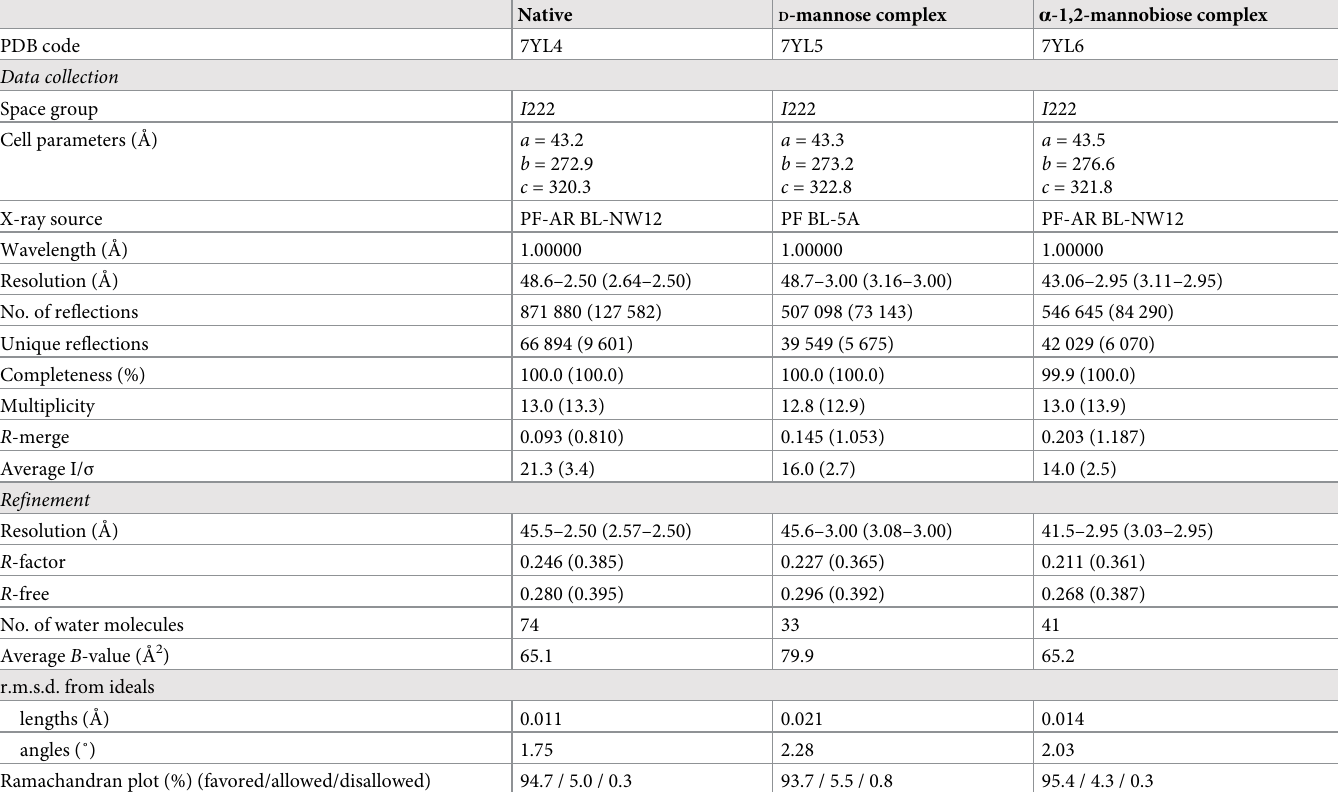
Table 2. Data collection and refinement statistics of the YwfG fragment